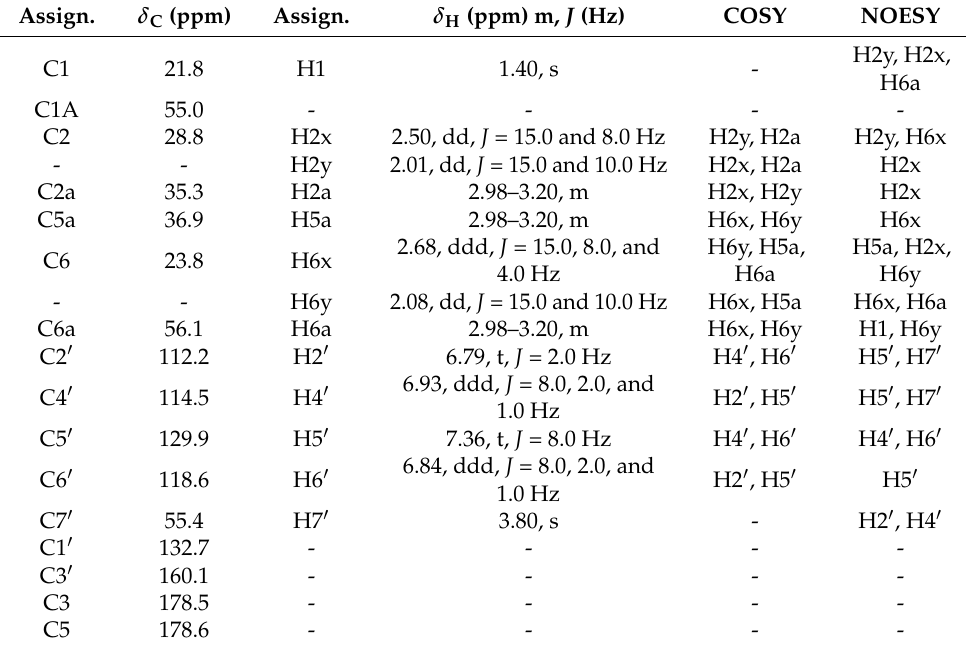
Table 3. Experimental 1 H and 13 C NMR chemical shifts, COSY, and NOESY correlations for com- pound 5a *.